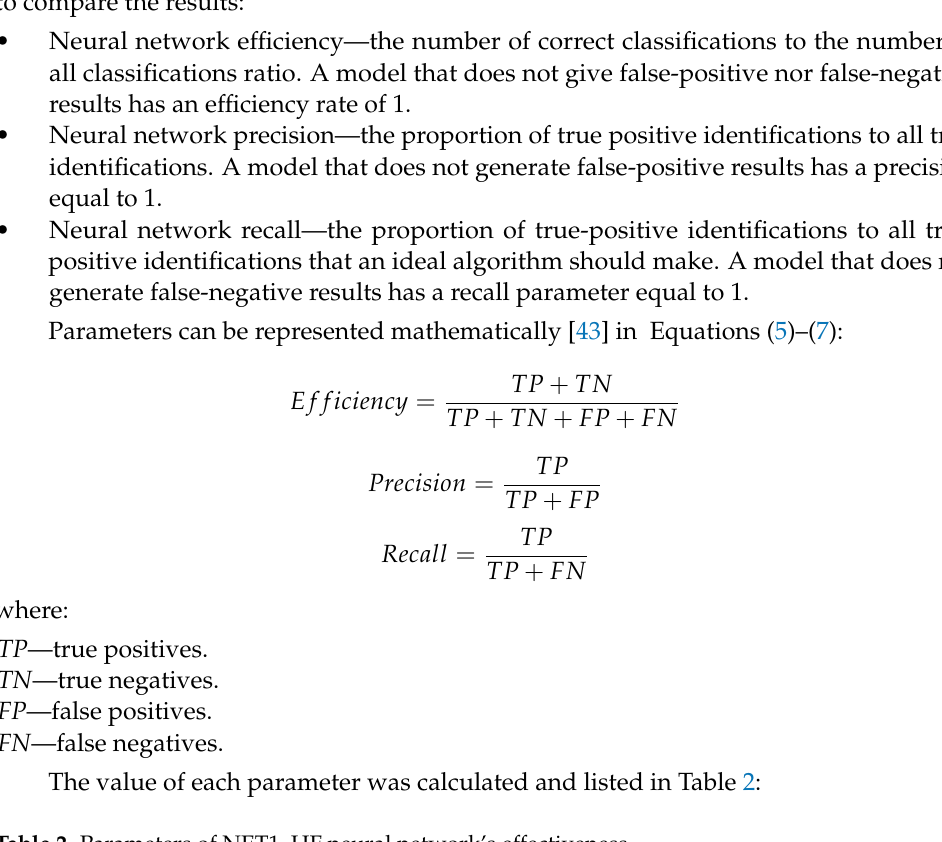
Table 2. Parameters of NET1_HF neural network’s